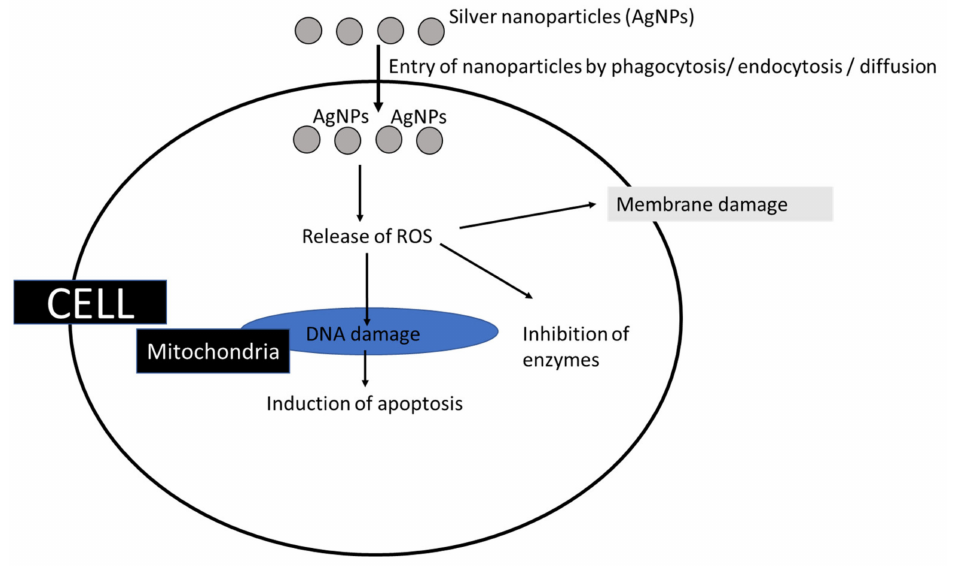
Figure 5. Role of silver nanoparticles as